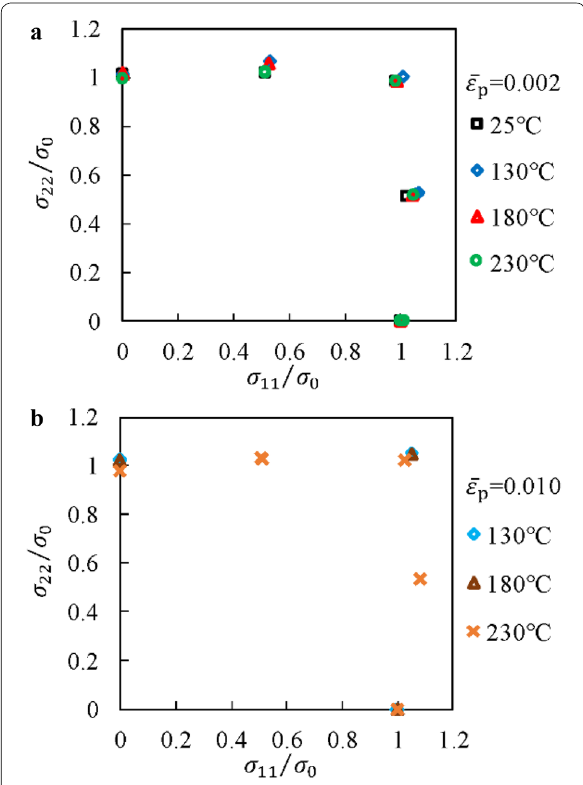
Figure 10 Normalized yield loci at ( a ) ε p = 0.002 and ( b ) ε p = 0.01 at various temperatures